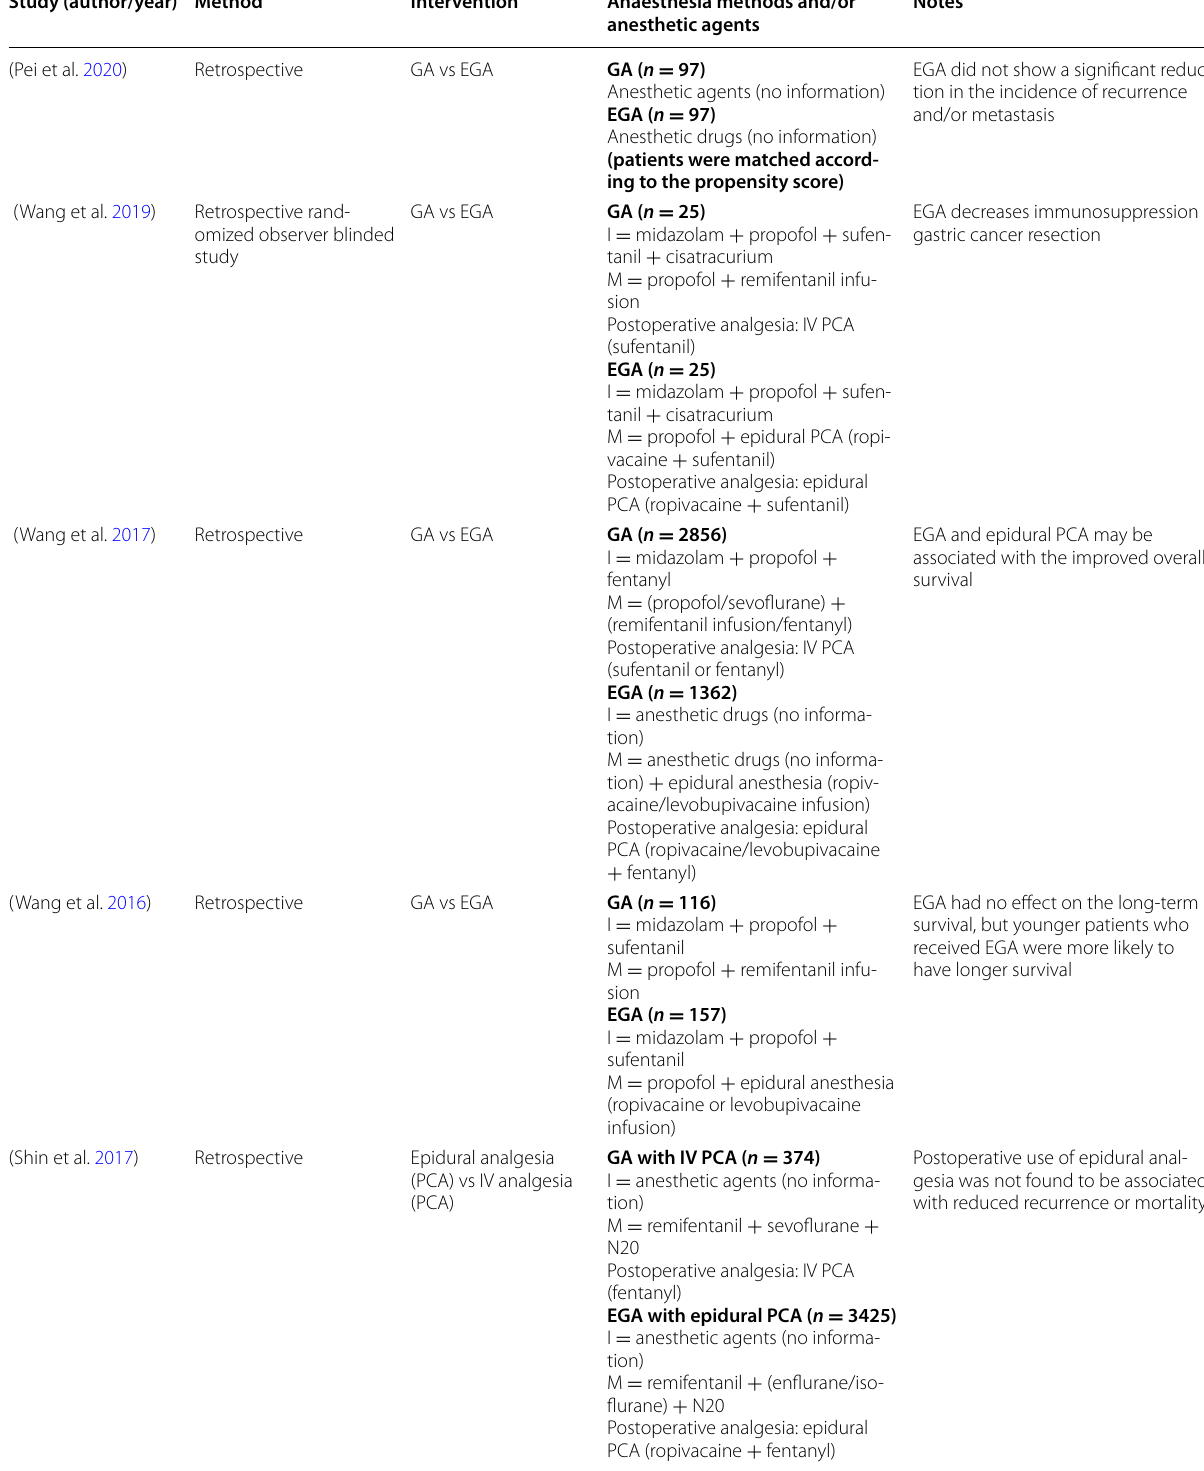
Table 2 Summary of studies on gastric cancer that compare GA with GA combined with epidural anesthesia/analgesia Study (author/year)